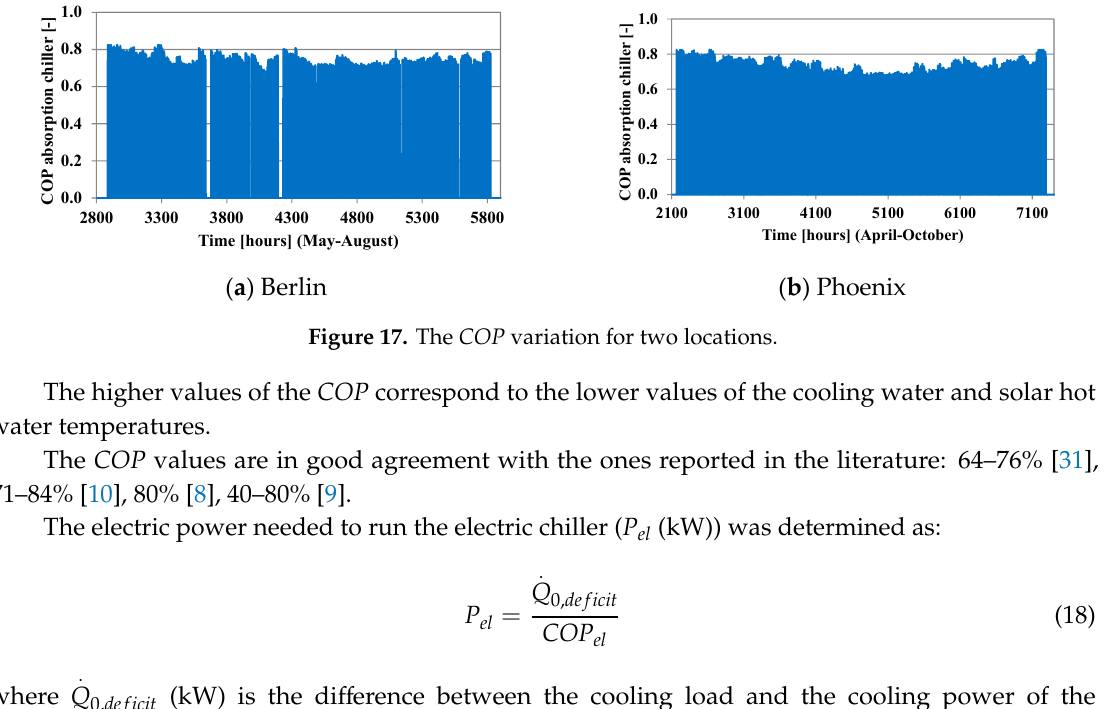
Table 6. COP correlation coe ffi cients.